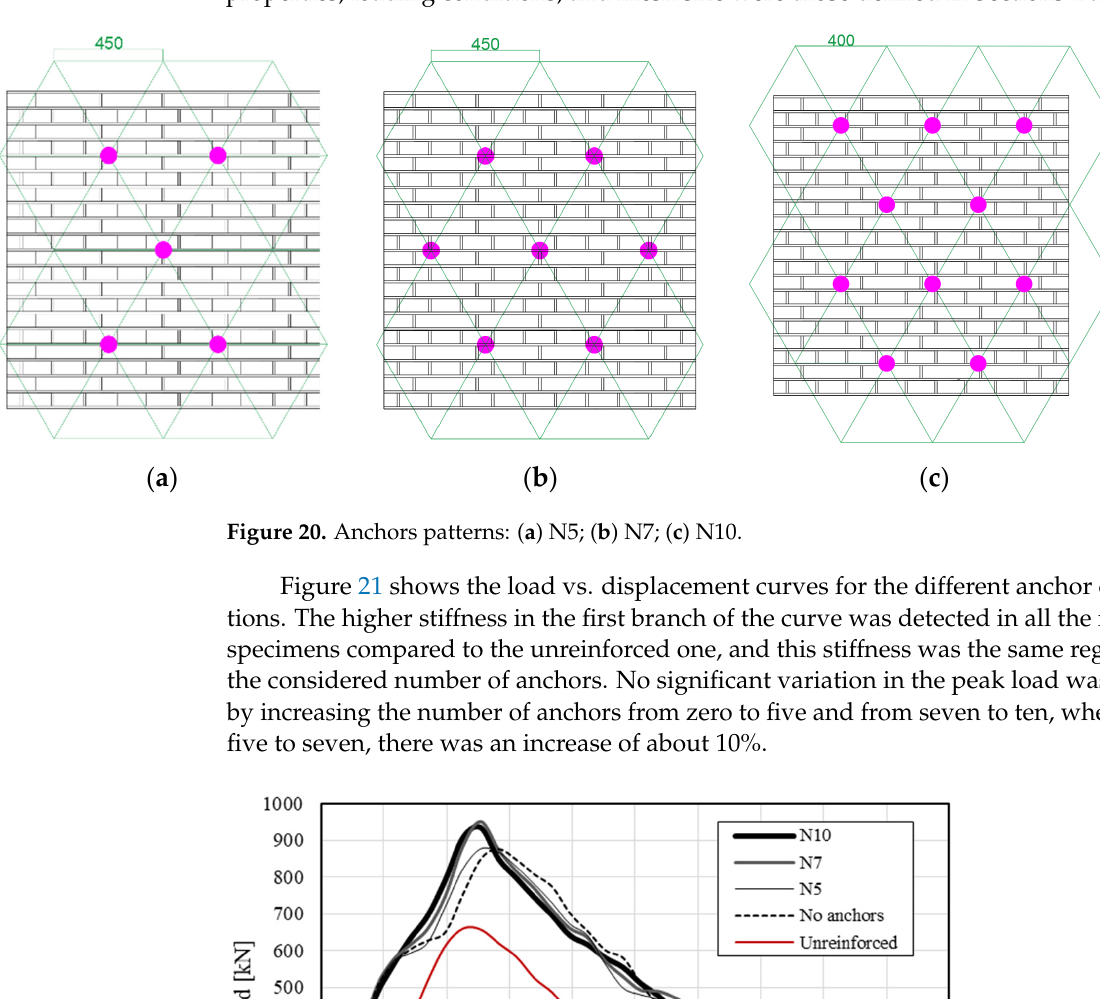
Figure 21. Load–displacement curves for different number of anchors.